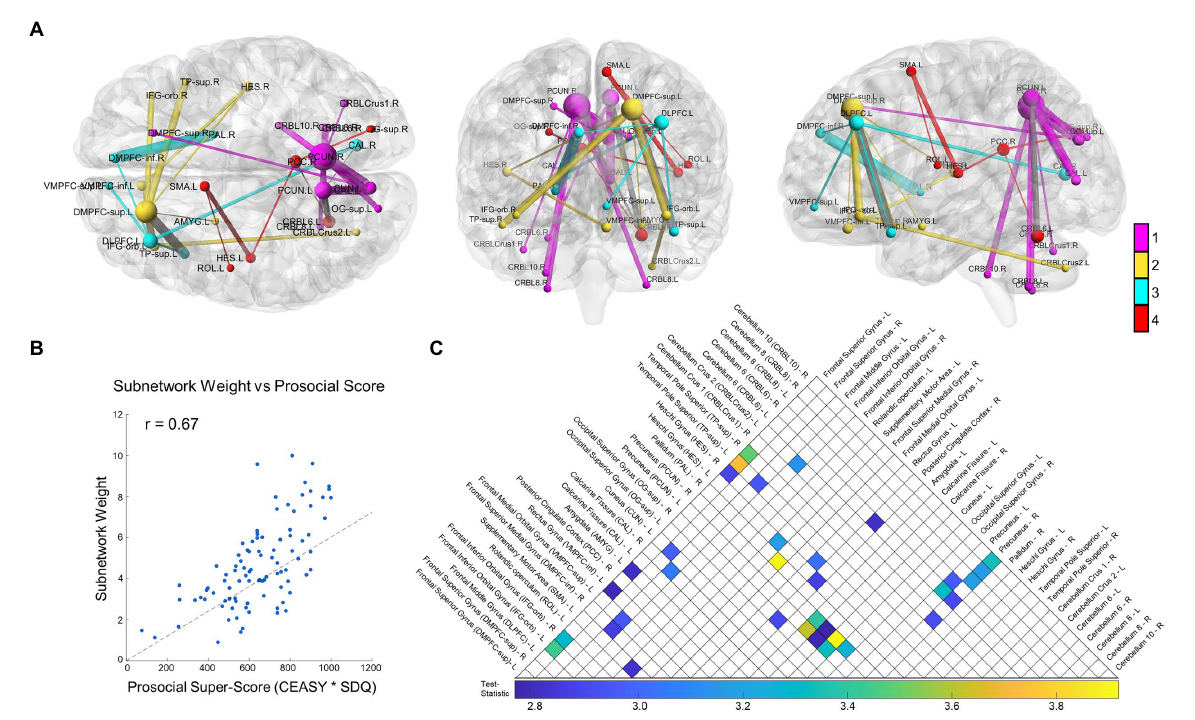
FIGURE 1 Study results. We show the overall results from the Network-Based Statistic (NBS) with resting state functional connectivity related to prosociality and compassion. (A) The NBS identified subnetwork is depicted from three orthogonal directions, from left to right: axial, coronal, and sagittal. For visualization, node size scales relative to that node’s degree (number of connections) and edge thickness scales relative to that edge’s test-statistic (relationship strength to prosociality and compassion). Network modules were identified using the Louvain community detection algorithm, and the nodes and edges are colored relative to their module (inter-modular edges shown in gray). In summary, the module shown in magenta centers on the bilateral precuneus and connects with the right DMPFC-inf, bilateral occipital lobe and cerebellum; the yellow module centers on the left DMPFC-sup and connects to regions including the bilateral IFG, left amygdala, and bilateral TP-sup, right Heschl’s gyrus, and left VMPFC; the cyan module centers on the left DLPFC and connects to regions including the right DMPFC-inf, left TP-sup, right calcarine fissure, and right pallidum; finally the red module is more central, connecting the PCC, to the occipital lobe, left Heschl’s gyrus, the Rolandic operculum, and the SMA. (B) A scatter plot showing the relationship between the total subnetwork weight (sum of all functional connectivity edge weights in the subnetwork) and the prosocial and compassion questionnaire scores. The dotted line shows the least-squares regression fit. The Pearson’s correlation is highly significant ( r = 0.67, p < 0.0001). (C) An upper-triangle of the adjacency matrix depicting the same network shown in (A) , with a list of all subnetwork regions defined by the AAL atlas along their respective row/column indices. The matrix entries visualize the edge test-statistic with colored values based on the underlying color bar. Brain networks in this figure were visualized with BrainNet Viewer (Xia et al.,